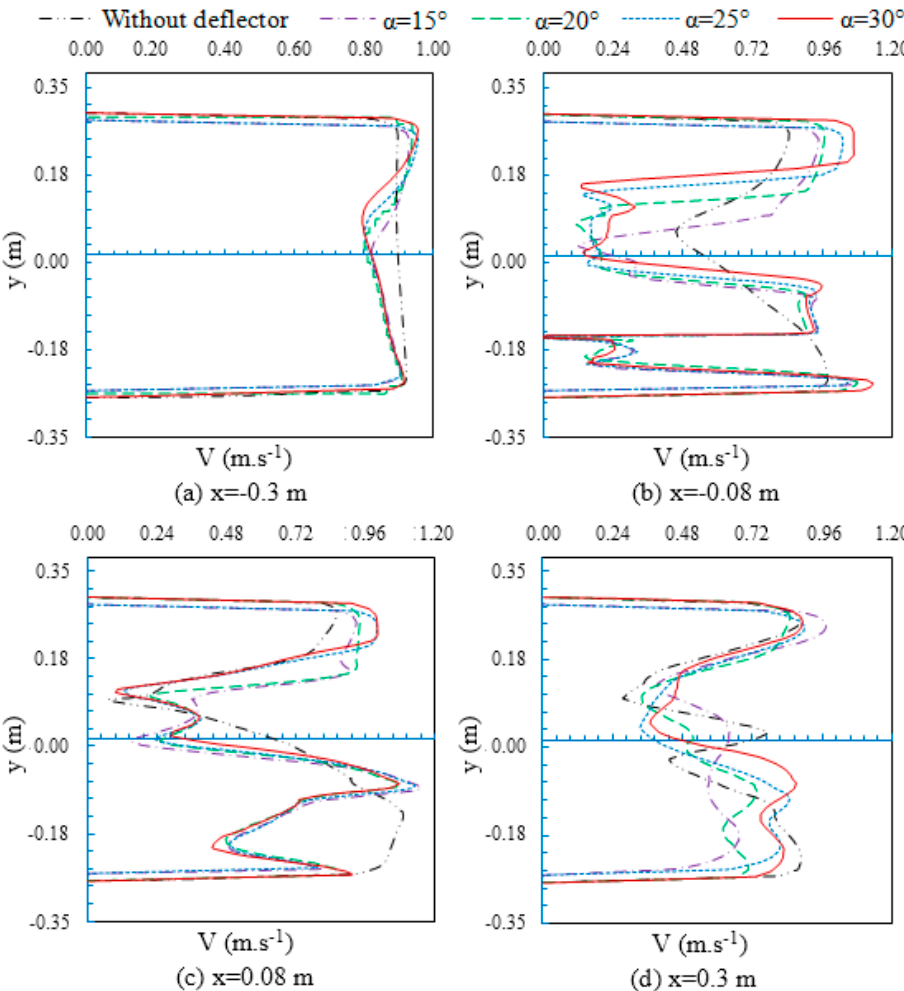
Figure 12. Velocity profiles for different deflection angles.